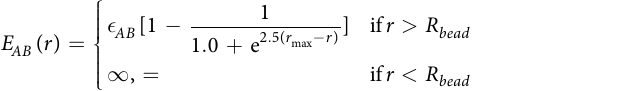
Figure 5. Interaction potentials. ( a ) Isotropic square-well like interaction as a function of the distance of the centers of the spherical monomers r (see left inset). The well depth is controlled by a pre-factor  different for each different pair of monomers. The pre-factors are grouped in an interaction matrix, the size of which depends on the number of monomer types in the range 3 to 20 (find the matrices used in the Supplementary Informations). For an alphabet of size N , the set of N ( N + 1)/2 heterogeneous interactions are Gaussian random numbers with zero average and standard deviation of 0.33 k B T Ref , similarly to protein coarse- grained protein models 23,65,66 , where T Ref is a reference temperature that sets the scale of interactions. Inset: schematic illustration of patchy polymers. Small white spheres indicate the patches. ( b ) Directional potential. The radial Lennard-Jones contribution in the plot is multiplied by the directional contribution (cos θ 1 cos θ 2 ) 2 , where θ 1 and θ 2 are the angles between the patch vector and the distance vector (right